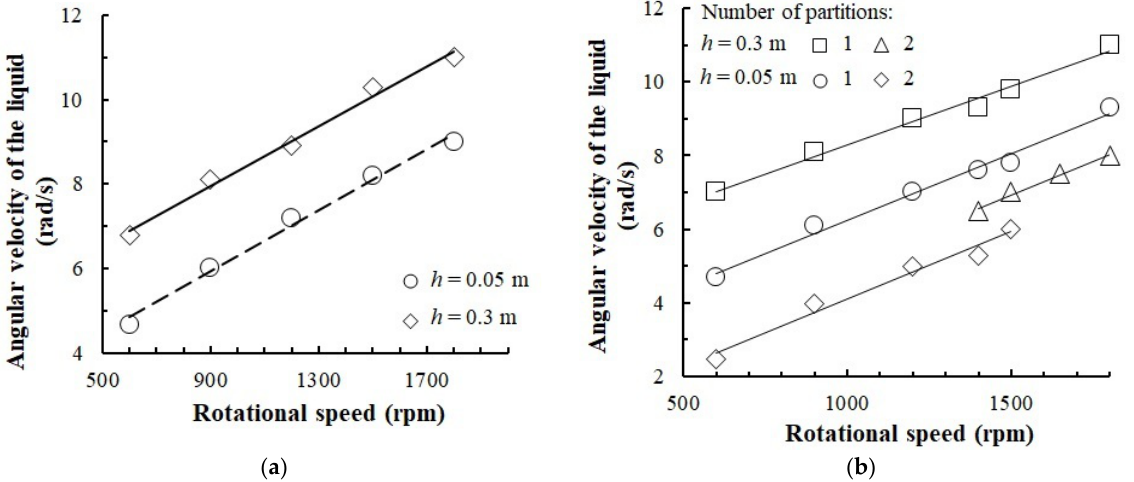
Figure 3. Change in the angular velocity of the gas–liquid medium at a rotational speed of H L / D = 1.2, D = 0.28 (m) apparatus without partitions ( a ) and apparatus with partitions ( b ) for a different paddle height h